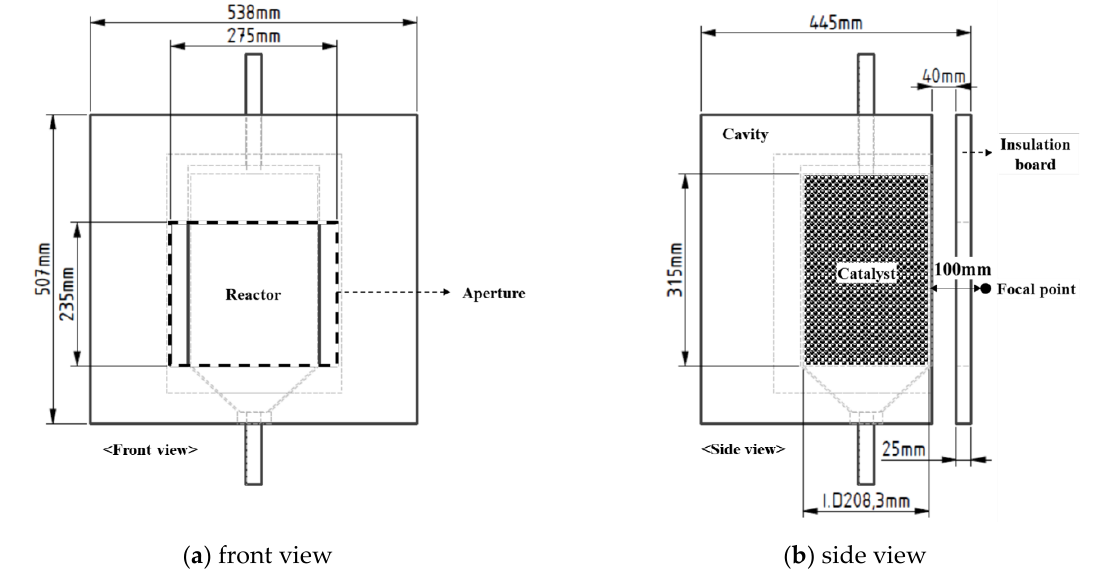
Figure 4. Semi-cavity reactor model.